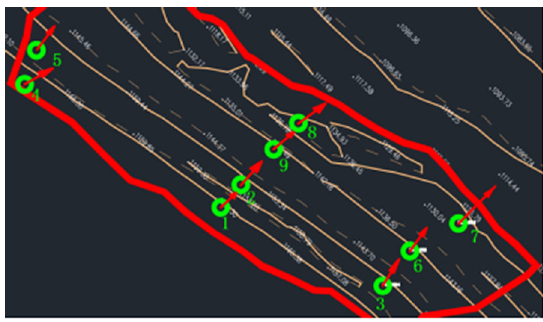
Fig. 5 Track of displacement vector of GPS monitoring points